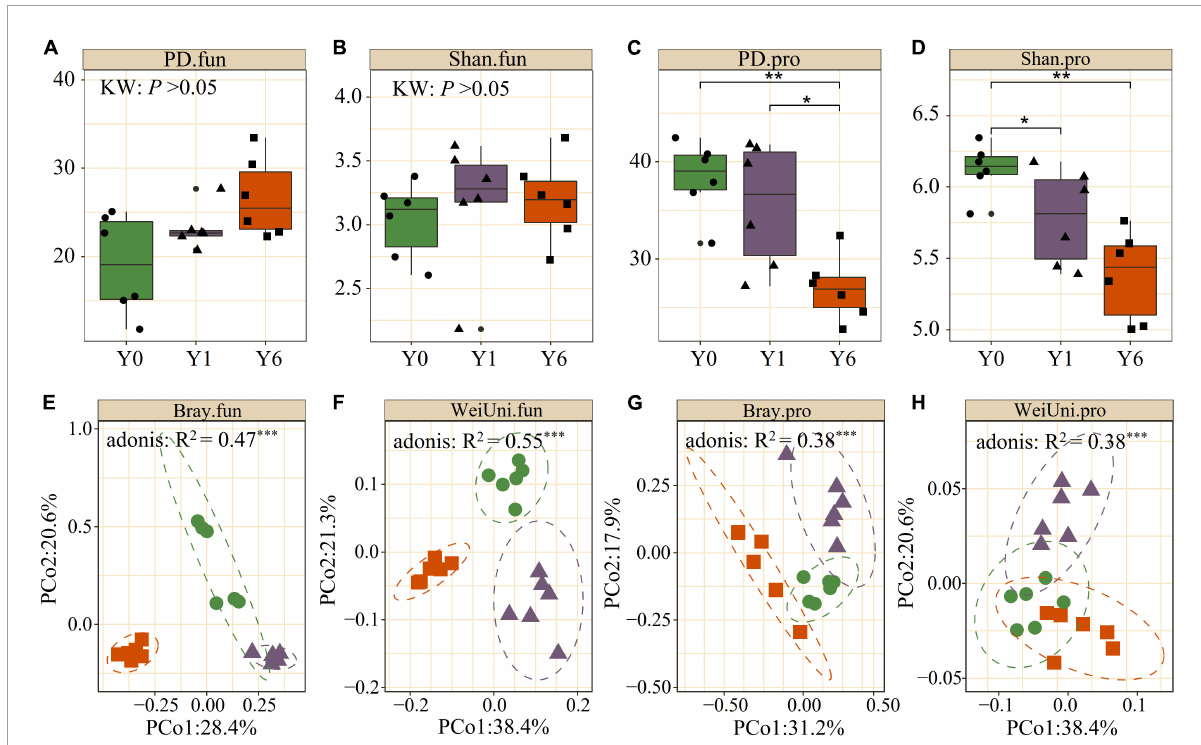
FIGURE2 Comparison of alpha and beta diversity across Y0, Y1, and Y6 soil samples. (A–D) are phylogenetic index (PD) and Shannon index (Shan) of soil fungal (.fun) and prokaryotic (.pro) communities. (E–H) are principle coordinate analysis (PCoA) of soil fungal and prokaryotic communities based on Weighted UniFrac (WeiUni) distance and Bray–Curtis (Bray) distance, respectively. * indicate p < 0.05, ** indicate p < 0.01, ∗∗∗ indicate p <